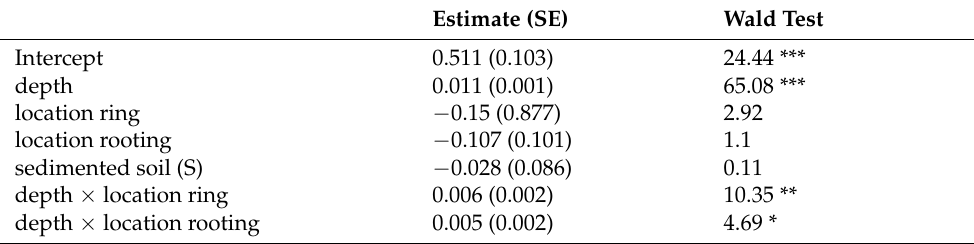
Table 2. Results of generalized estimating equations on soil compaction data.